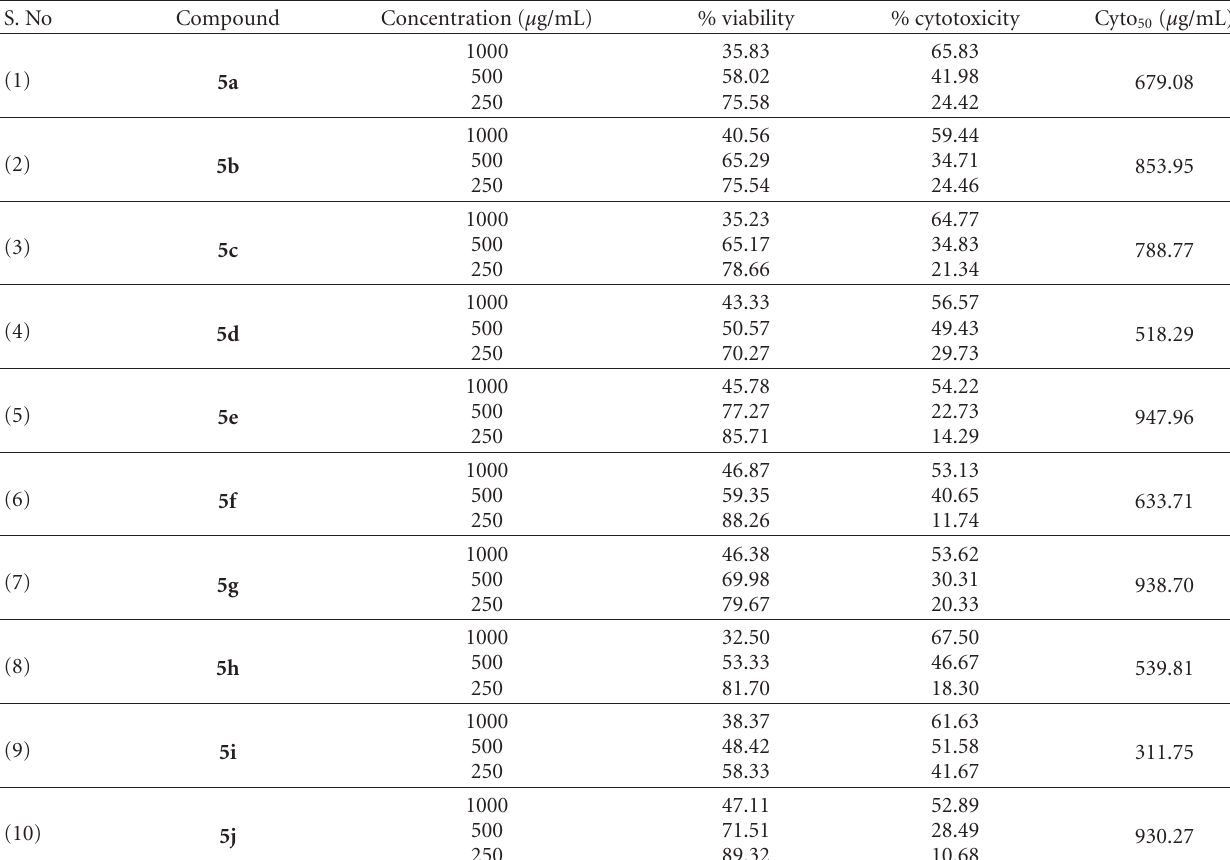
Table 2: Short term in vitro anti-tumor activity of synthesized compounds against Daltons Lymphoma Ascites (DLA) cells. S.